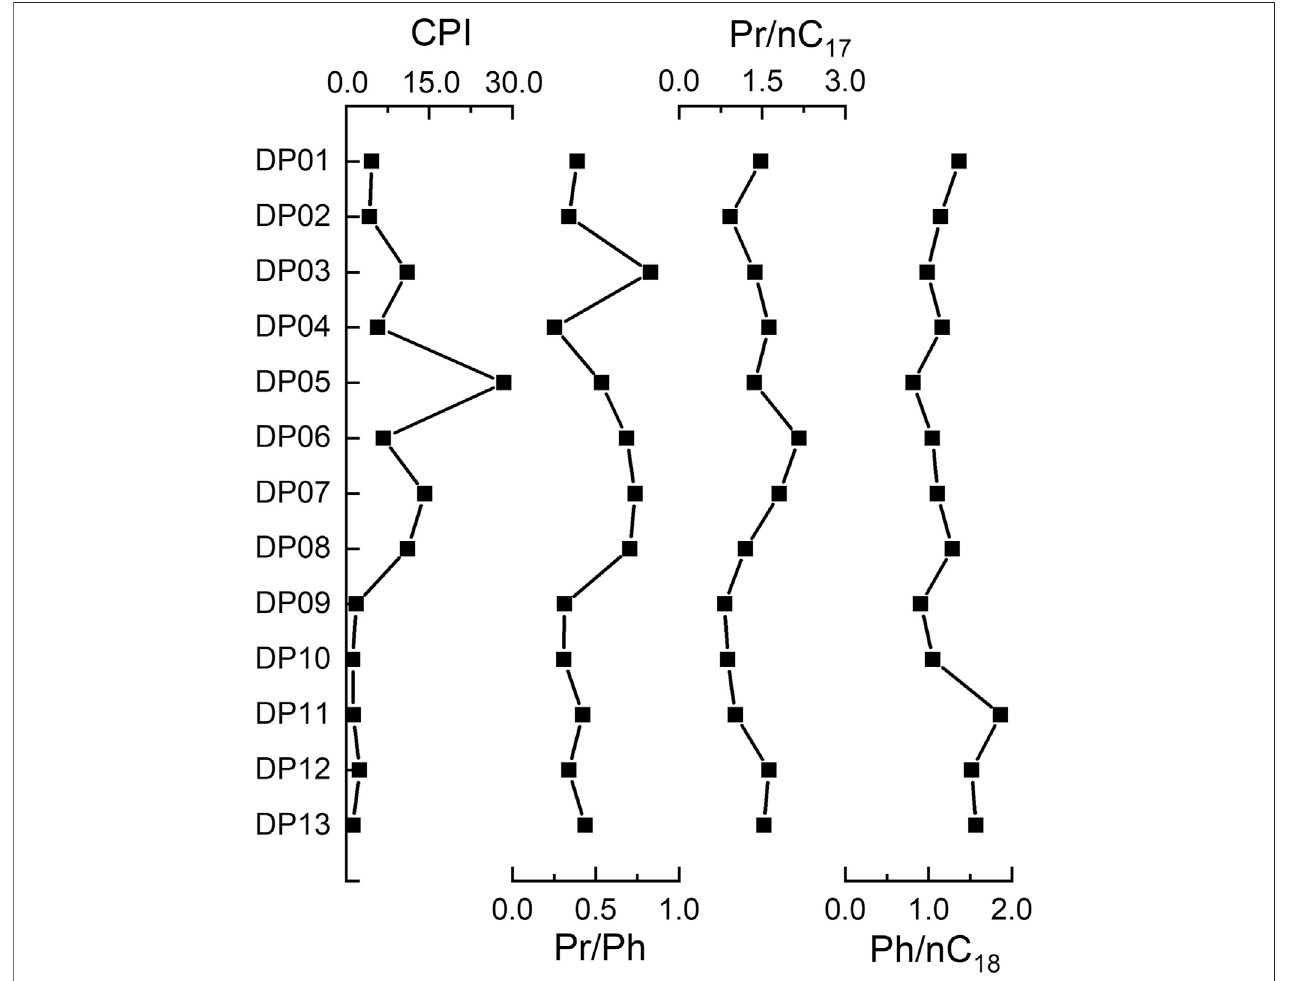
FIGURE 8 | CPI, Pr/Ph, Pr/nC 17, and Pr/nC 18 values of 13 samples from the East Taijinar salt lake sediments.